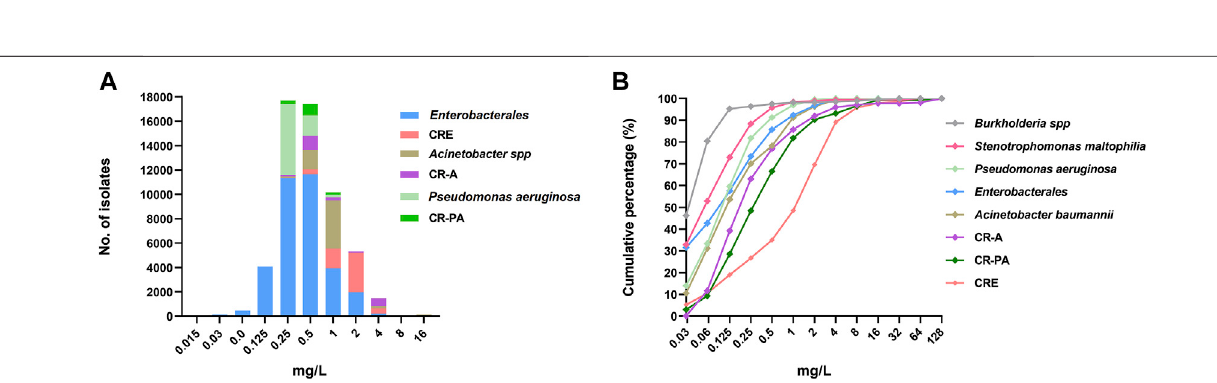
Frontiers in Pharmacology |